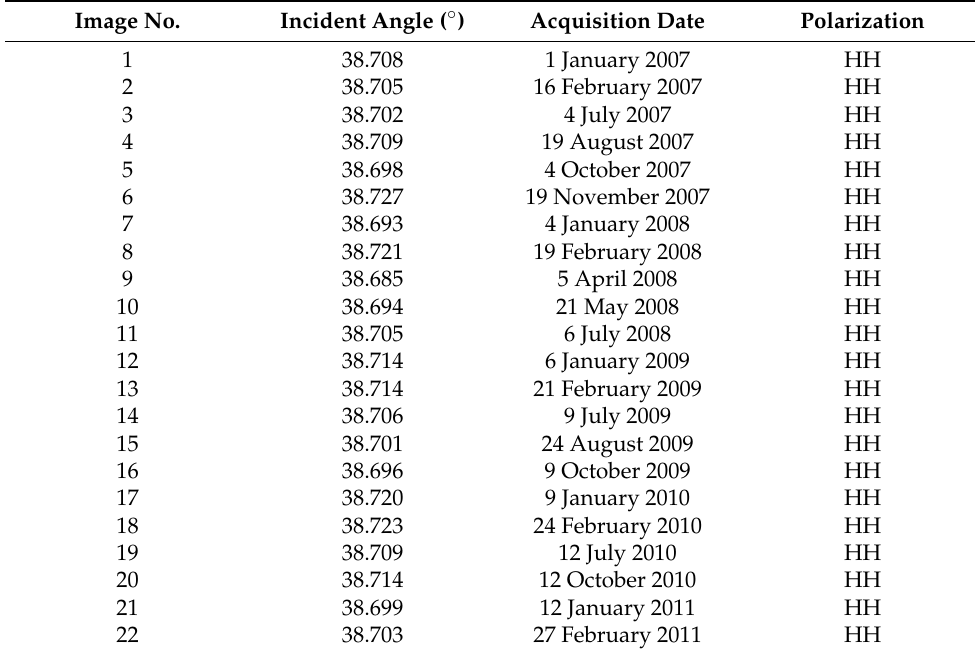
Table 1. Parameters of the ALOS PALSAR images in the research area. Image No. Incident Angle ( ◦